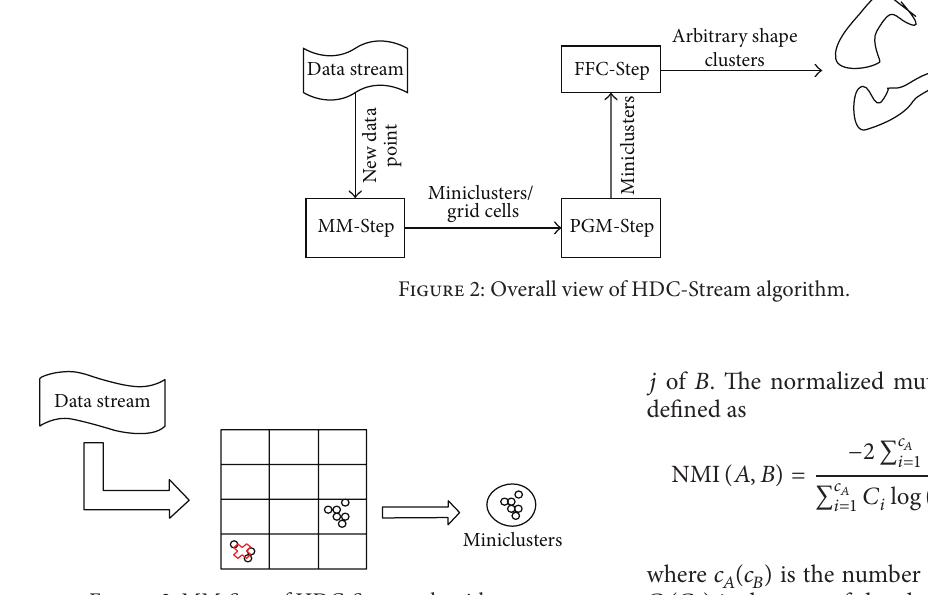
Figure 3: MM-Step of HDC-Stream